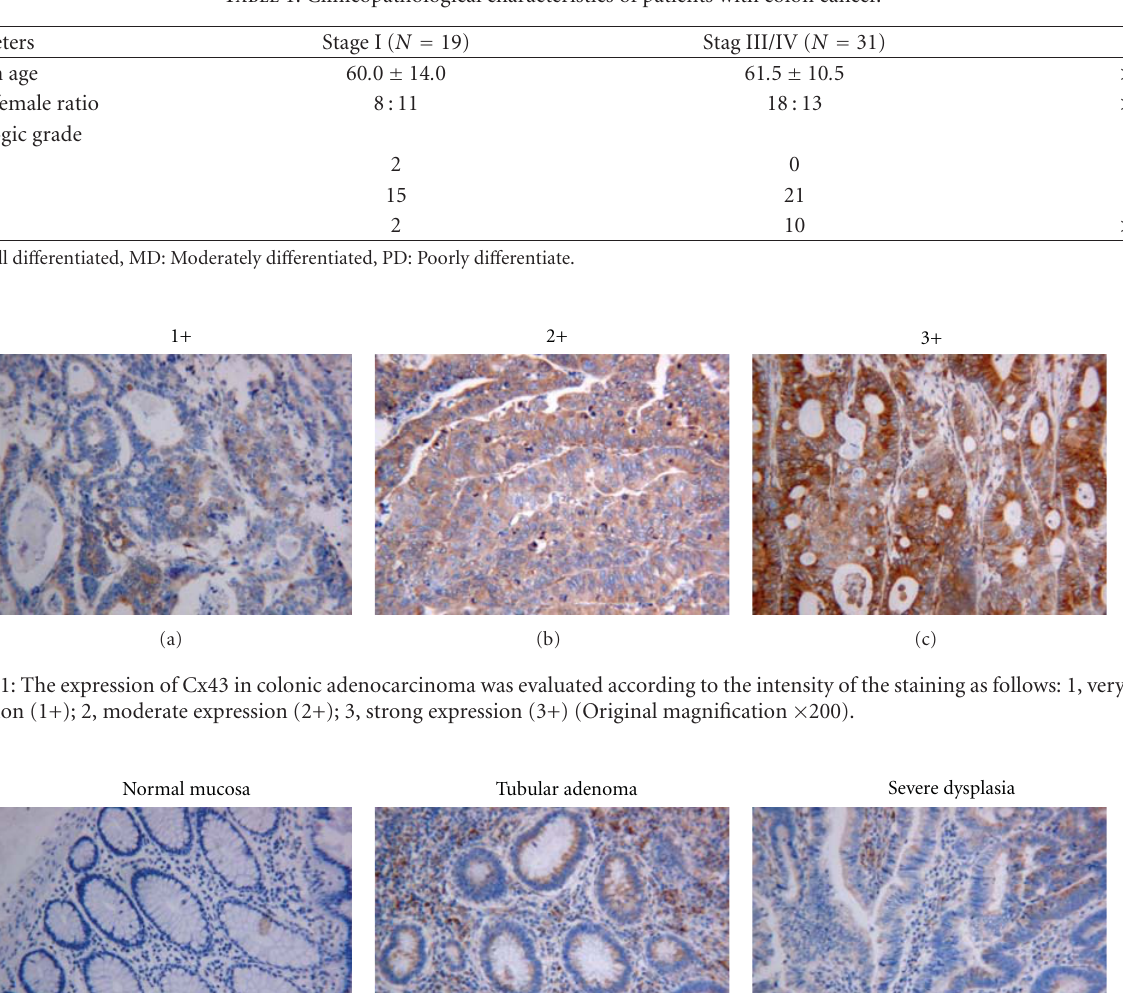
Table 1: Clinicopathological characteristics of patients with colon cancer.